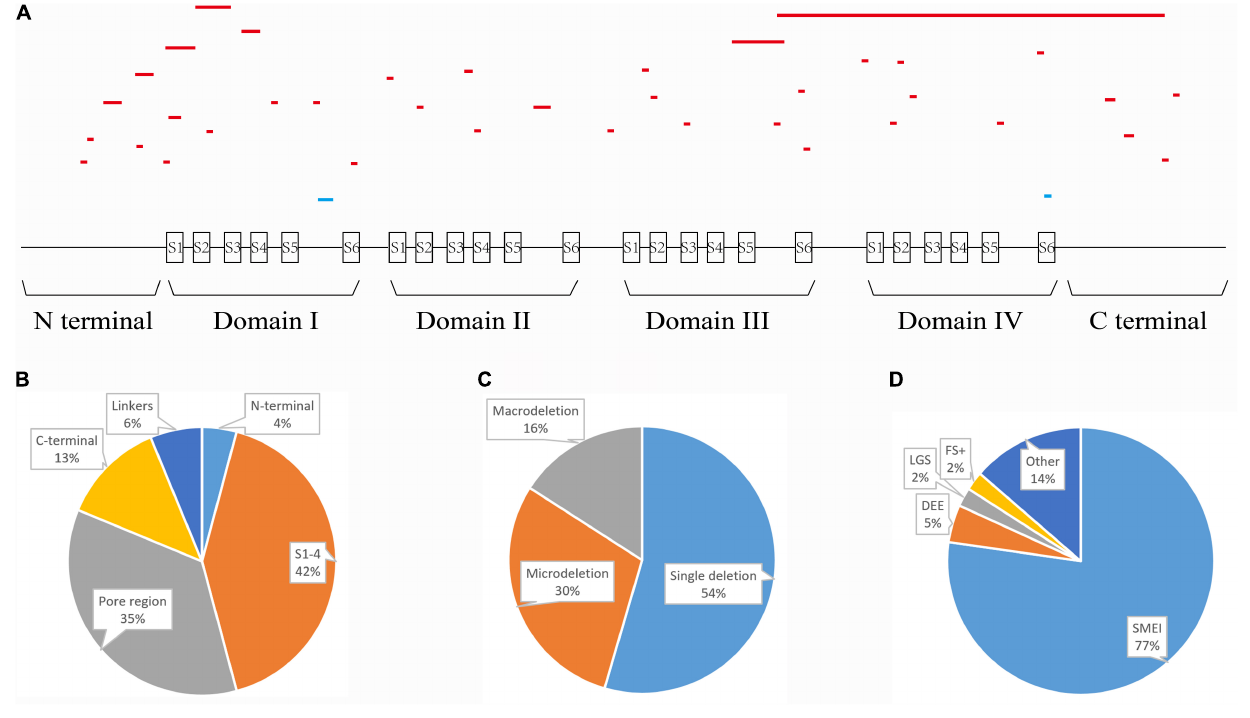
FIGURE 2 | Statistics of all in-frame deletions in SCN1A . (A) Schematic picture showing the length, location, and phenotypes of the 44 variants. Lines indicate different variants. Severe phenotypes (SMEI, DEE, and LGS) were highlighted as red, while mild phenotypes (PEFS+ and FS+) were blue. (B) Distribution of the variants on different functional domains. (C) The proportions of single deletion, microdeletions, and macrodeletions. (D) Phenotypic